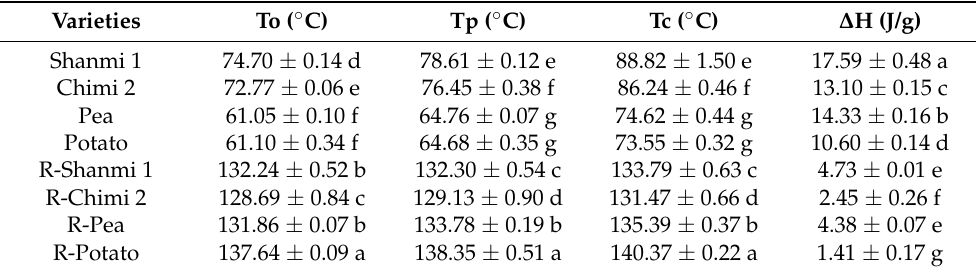
Table 3. Thermal properties of NS (natural starch) and RS (resistant starch).